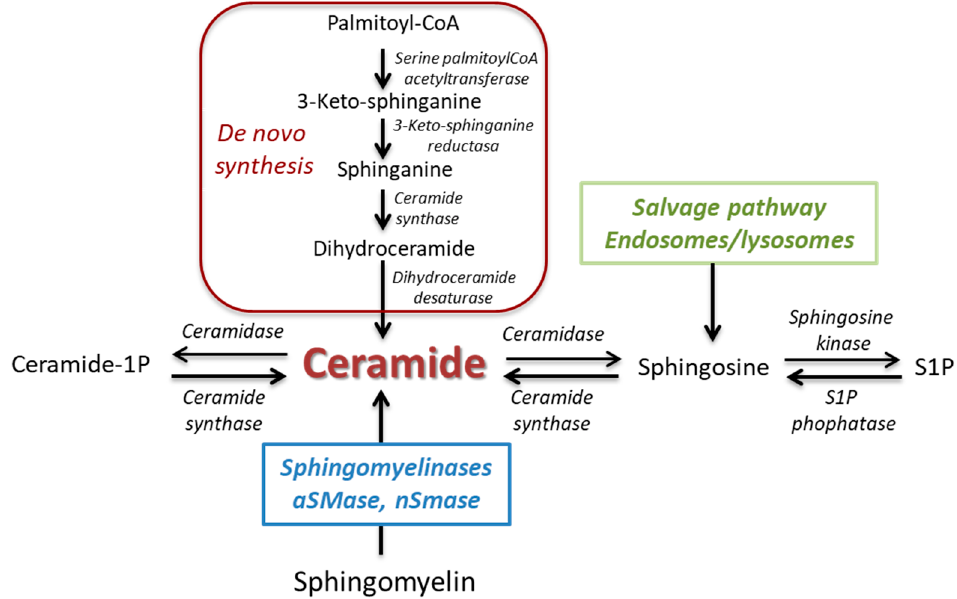
Figure 1. Synthesis and metabolism of ceramide.